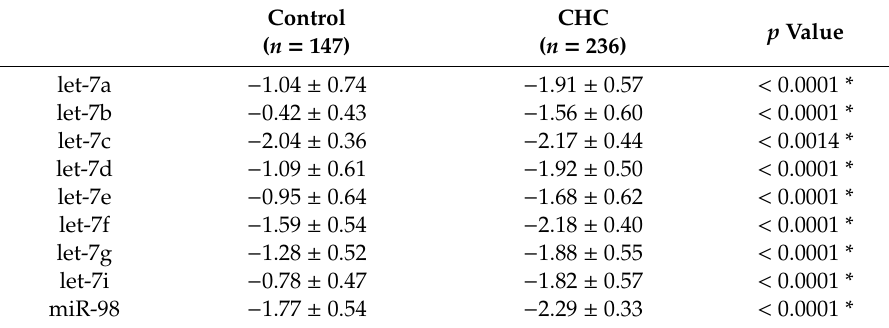
Table 2. Circulating let-7 family expression at baseline (Log 10 2 −(cid:52) C t ) 1 .